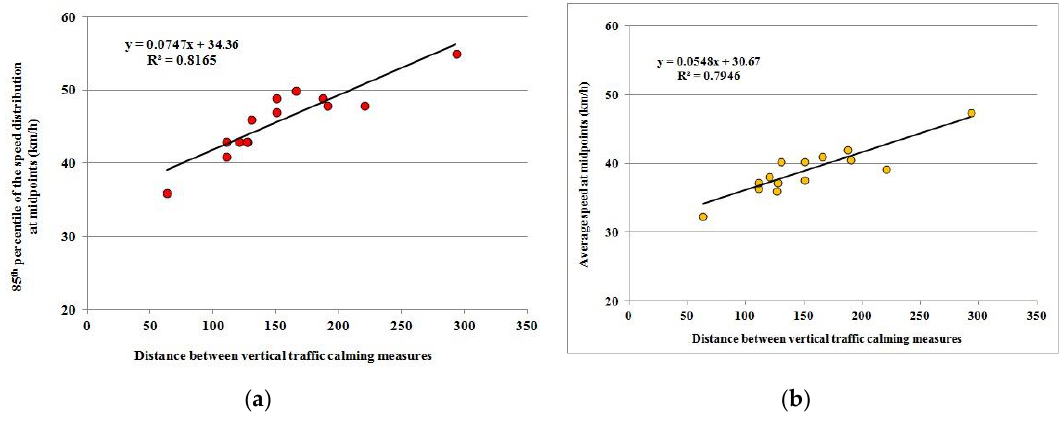
Figure 10. Plots of the proposed models: ( a ) Equation (1); ( b ) Equation (2). Table 4. Analysis of the Variance of the model of Equation (1).